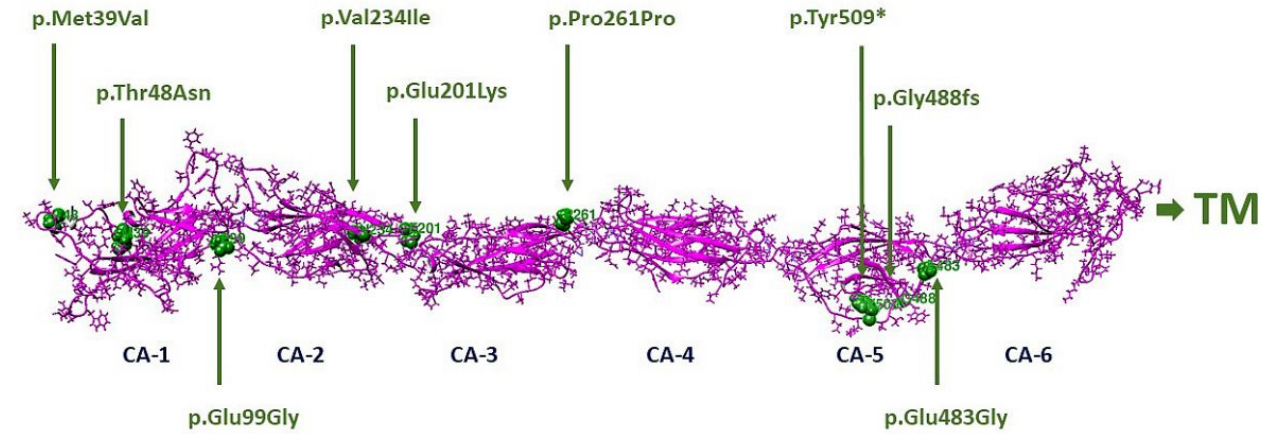
Figure 1. Locations of amino acid changes (green) in the CDHR1 domain structure (pink, residues 1–698). Structural domains were initially localized using SMART: Sequence analysis results for CDHR1_HUMAN (embl.de). Cadherin domains were CA-1 (residues 36–135), CA-2 (136–246), CA- 3 (247–353), CA-4 (359–472), CA-5 (473–576), and CA-6 (residues 36–135). The transmembrane helix, TM (702–724), is not shown.